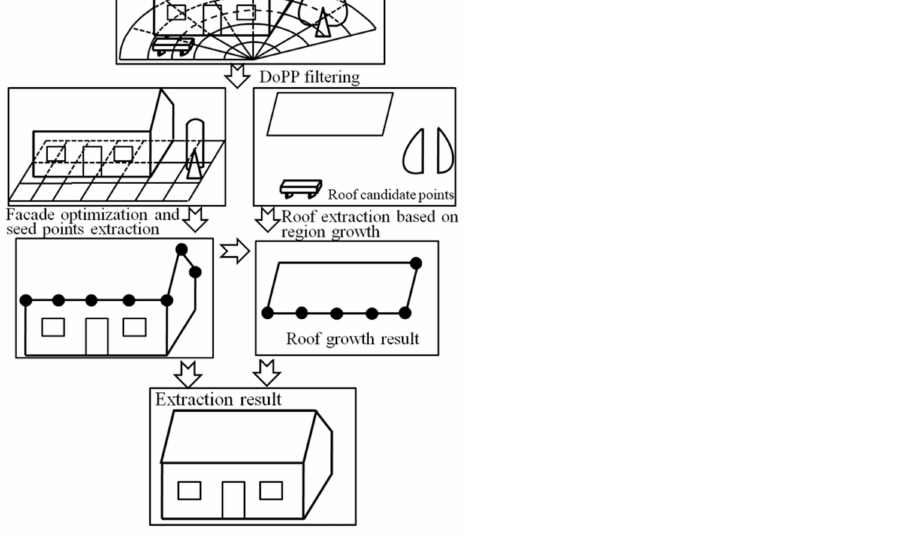
Figure 1. Process of the proposed method. Notice that all polygons here represent point clouds instead of